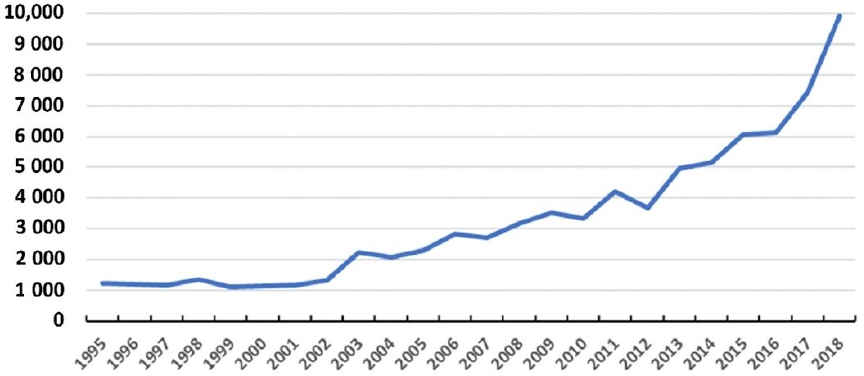
Figure 1. Number of Legionnaires’ Disease Cases Reported Annually in the United States.